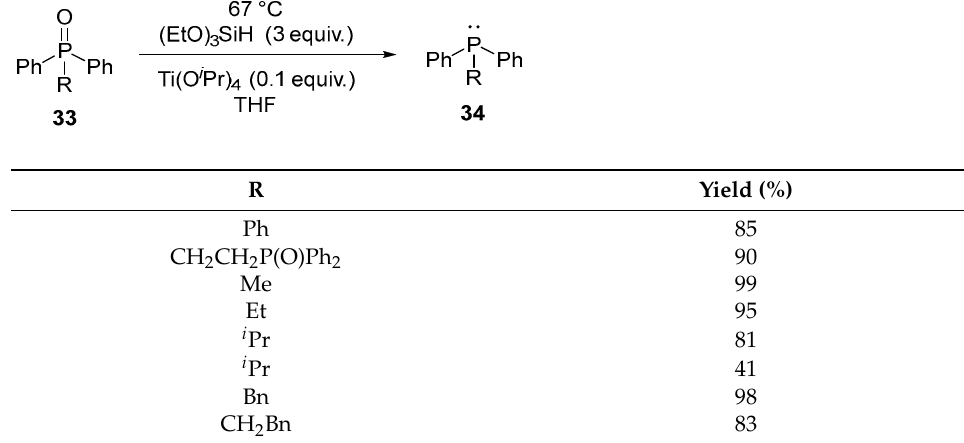
Table 9. Reductions with triethoxysilane.